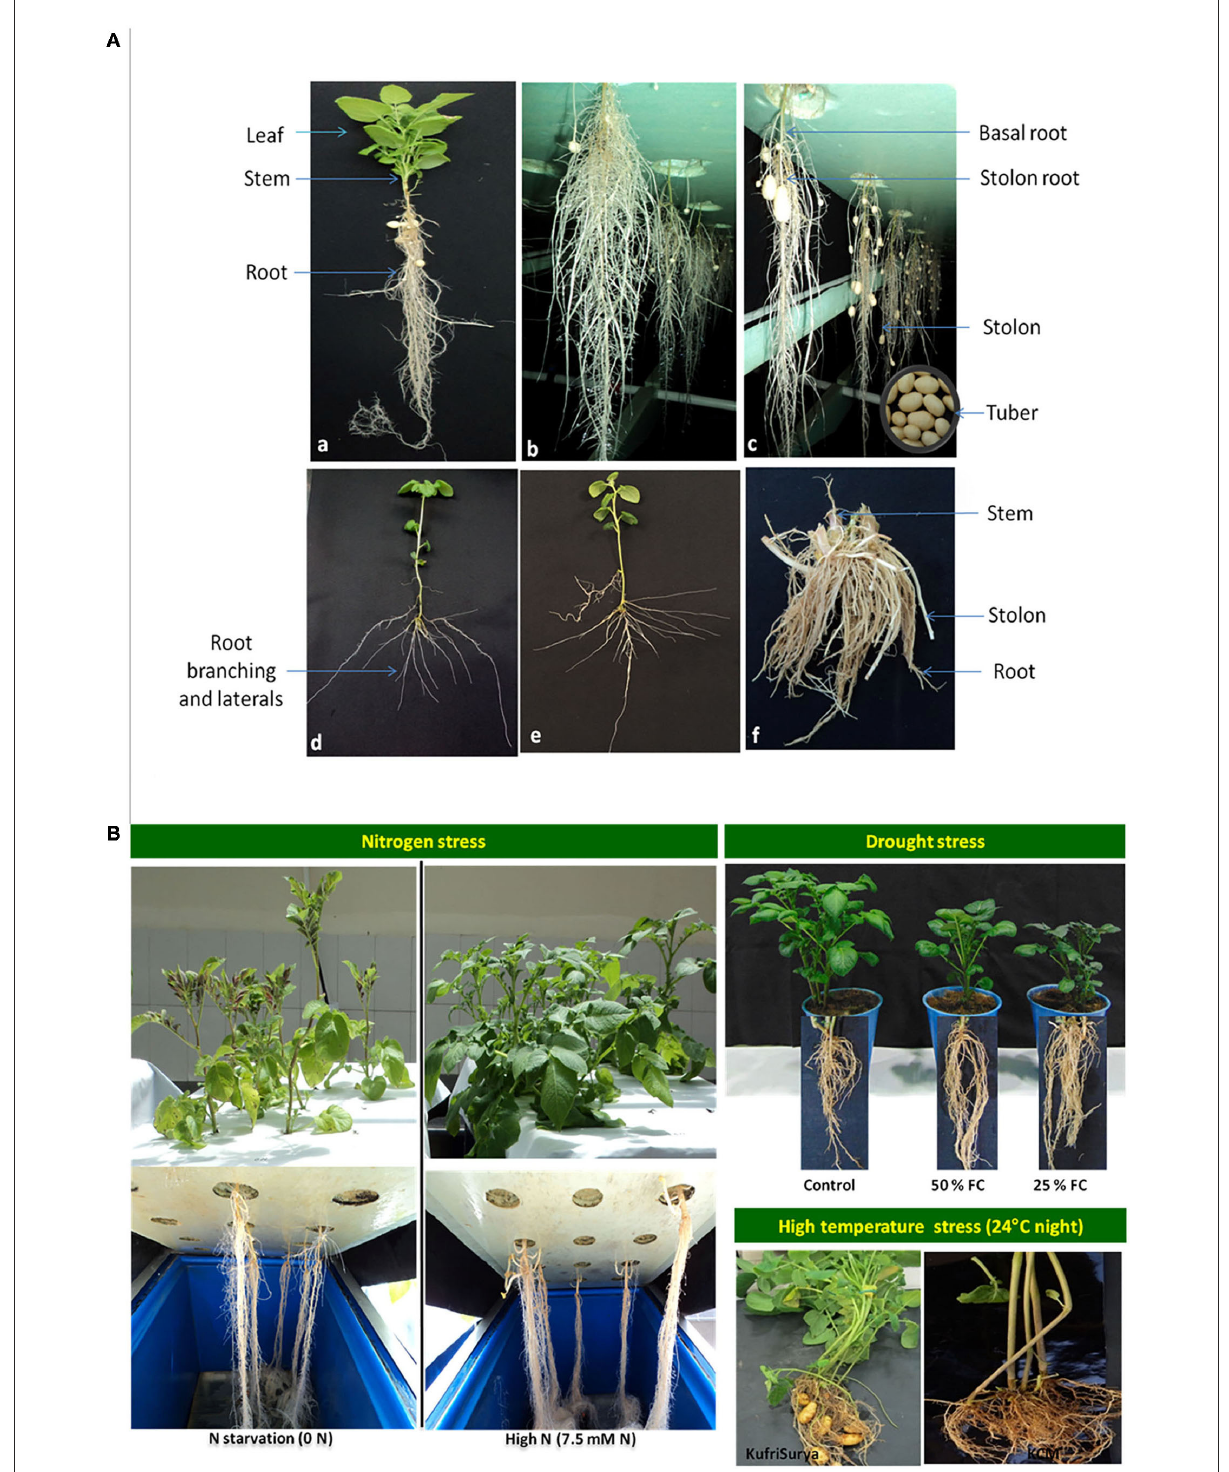
FIGURE1 (A) Illustrates the root biomass and tuber growth in potato plants grown under aeroponics: a) complete plant growth including root biomass at 45 days after planting (DAP), b) root architecture showing root volume and tuber initiation under hanging roots in aeroponics system at 45 DAP, c) fully grown tubers and harvesting of minitubers at 50 DAP ( < 5g each), d, e) pattern of root branching and laterals development at a very early stage (10 days-old seedlings), and f) root biomass of plants at harvesting stage (90 DAP) grown in the field with limited N (50 kg/ha) supply. (B) depicts plant phenotype (foliage and roots) under different stresses like nitrogen (left) ( N starvation vs. high N ), drought (right top) (control, 50% field capacity and 25% field capacity) and high temperature stress (right bottom) ( > 24 ◦ C night